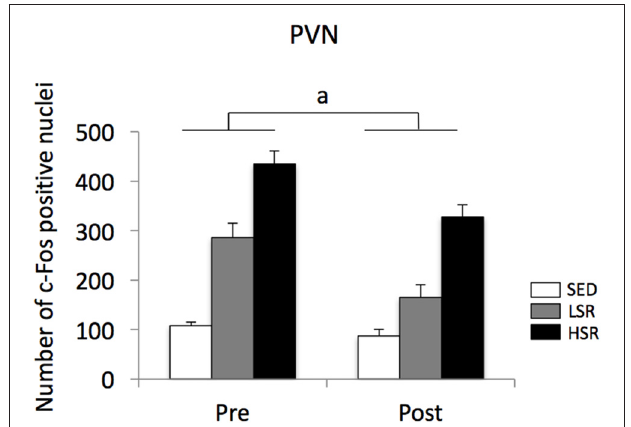
FIGURE 3 | Mean ( ± SEM) numbers of c-Fos positive nuclei in the DRN of rats after acute treadmill running at different intensities in the pre- and post-training groups. SED, sedentary controls; LSR, low-speed runners; HSR, high-speed runners. ∗ p < 0.05 vs. SED, a p < 0.05 vs. HSR in the pre-training group. F ( 2,27 ) = 15.775, p < 0.01, respectively). Post hoc analysis showed